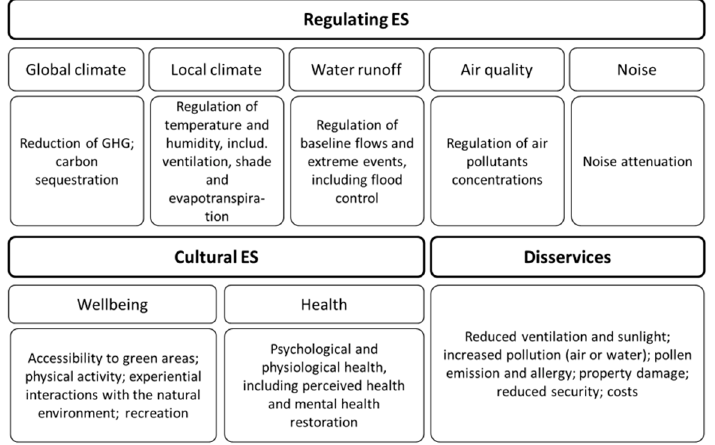
Figure 2. Main Ecosystem Services (ES) and disservices, their processes and effects covered by the review. ES classification adapted from [11,12,14].